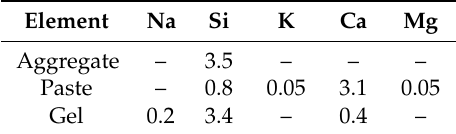
Table 4. EDX chemical analysis of aggregate, paste, and gel shown in Figure 4b.